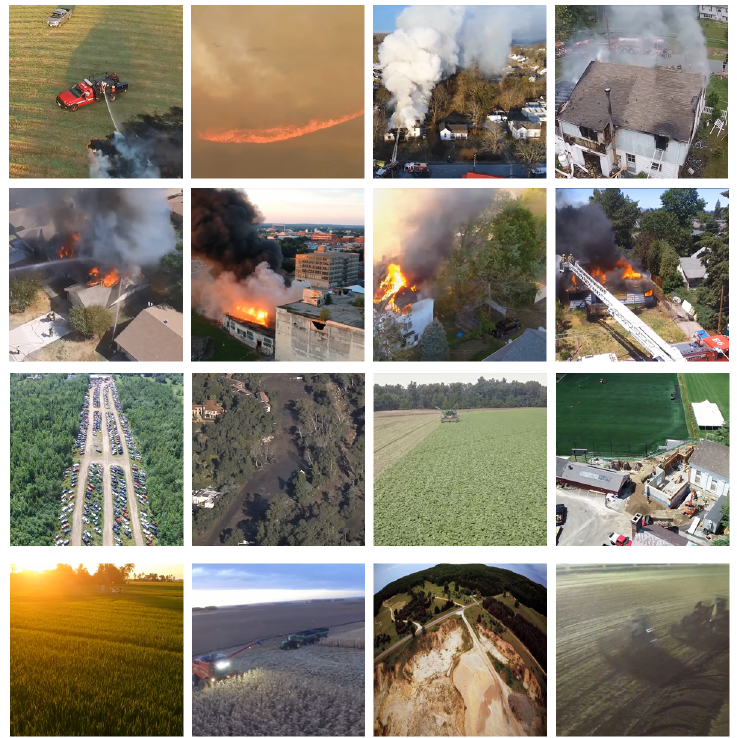
Figure 5. Portions of the video clips from our UAV fire dataset: The first two rows contain fire samples, and the bottom two rows have non-fire